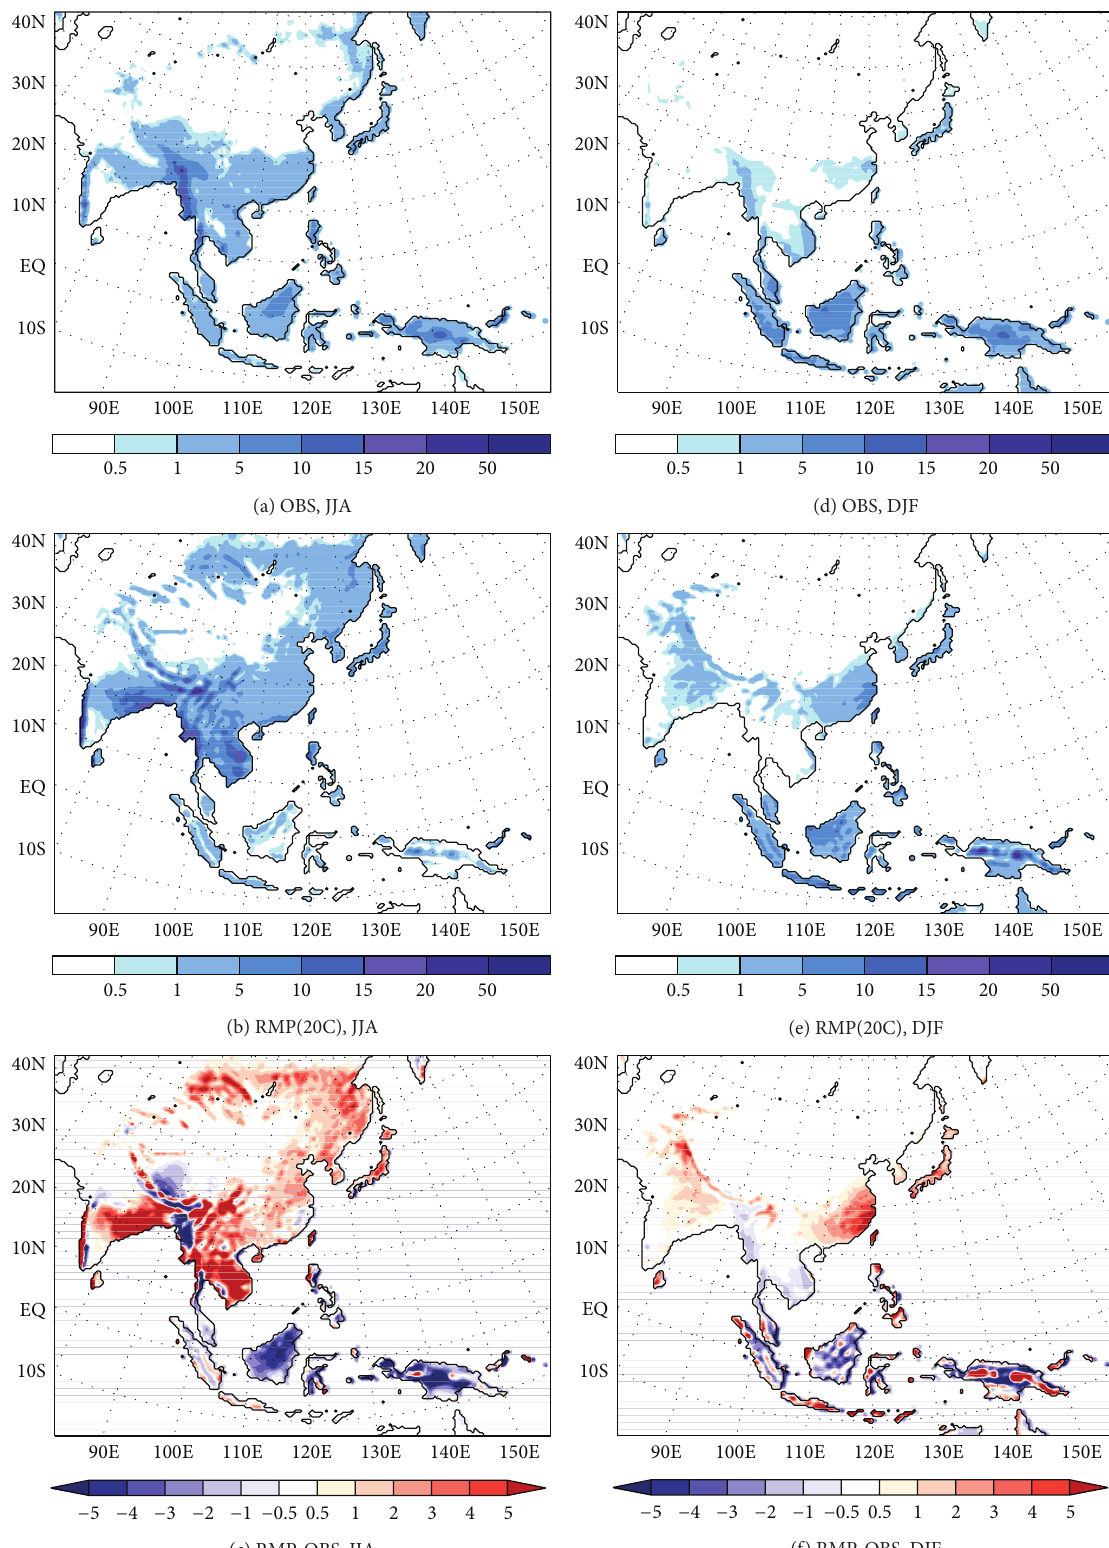
Figure 2: Seasonally averaged runoff (mm d −1 ) obtained from (a) observation (ISLSCP2), (b) model 20C experiment, (c) and their difference (model minus observation) for JJA. (d) to (f) are same as (a) to (c) but for